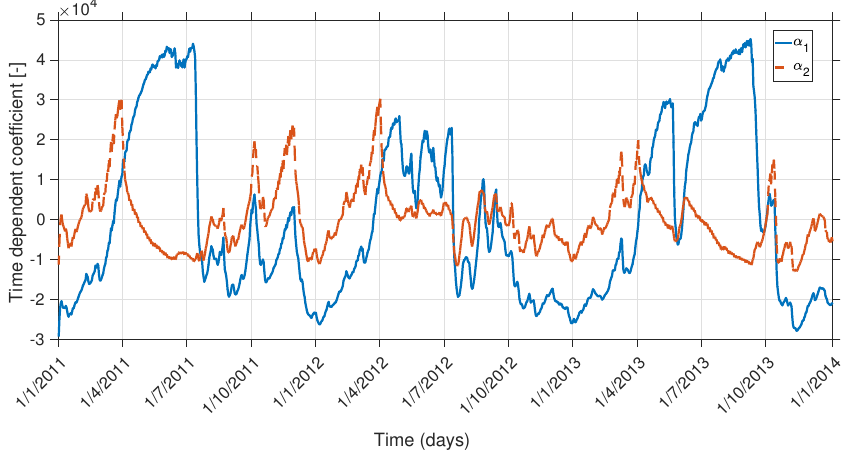
Figure 6. Time-dependent coefficients, α ( t ) , of the first two